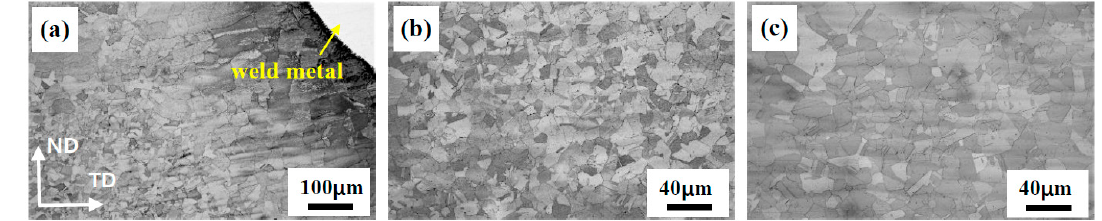
+ 2 mm location and ( c )